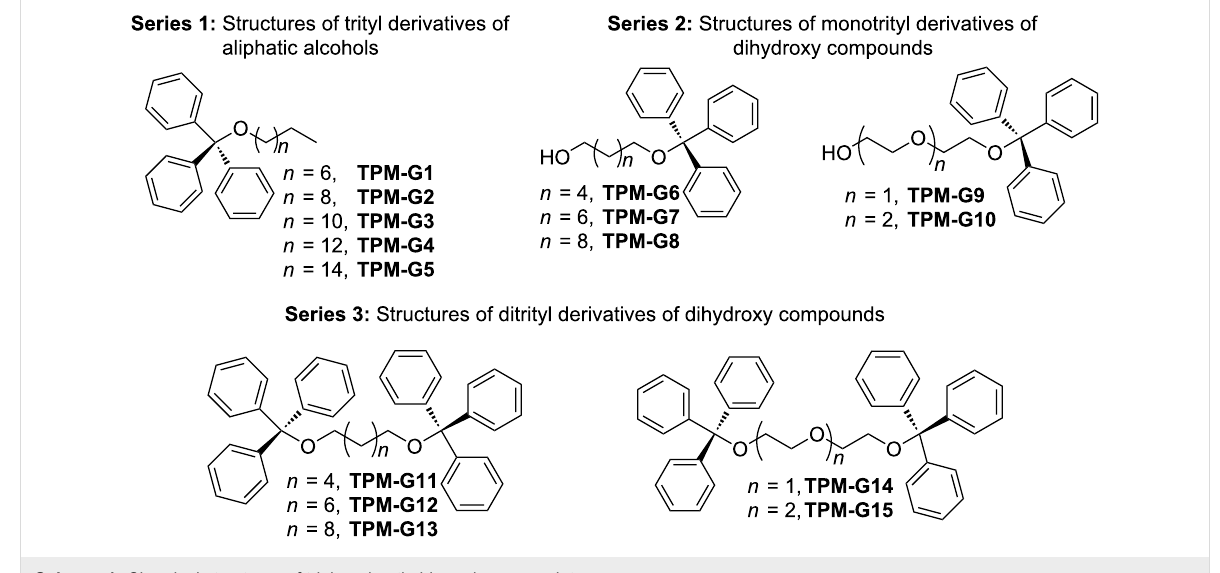
2-ol, butan-1-ol, butan-2-ol, diethylene glycol, and triethylene glycol. TPM-G5 (trityl derivative of 1-hexadecanol) formed an organogel in DMSO while TPM-G4 (trityl derivative of 1-tetradecanol) was able to gel diethylene glycol and tri-